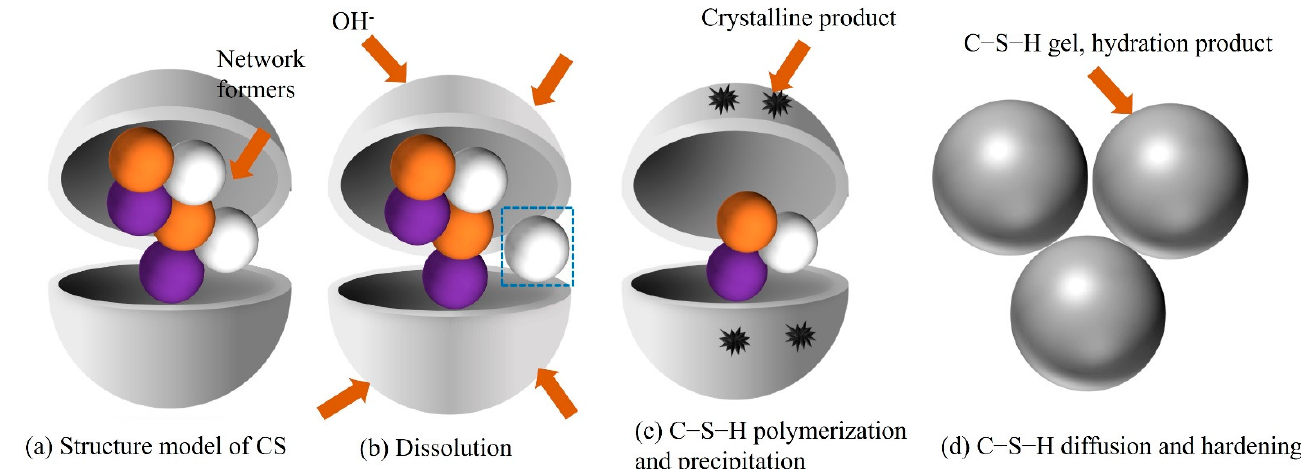
Figure 9. Mechanism of coupled mechanical–chemical activation of copper